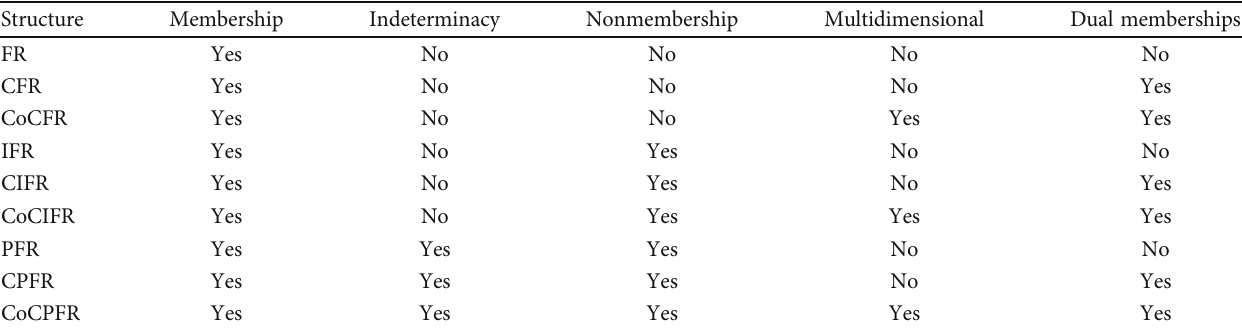
Table 7: A complete comparison among all the structure based on di ff erent fuzzy